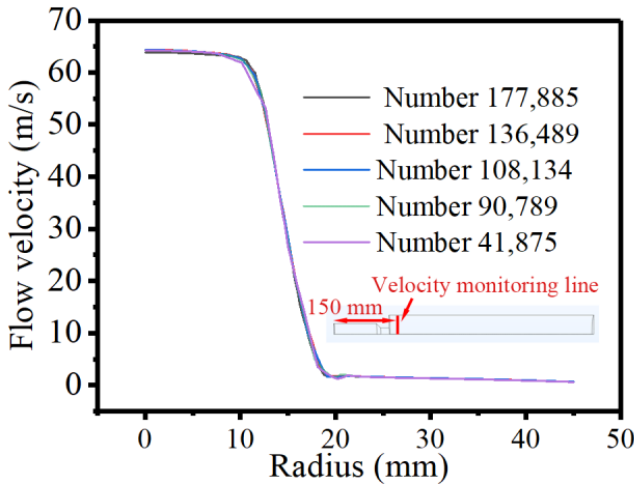
Figure 3. Grid independence study.